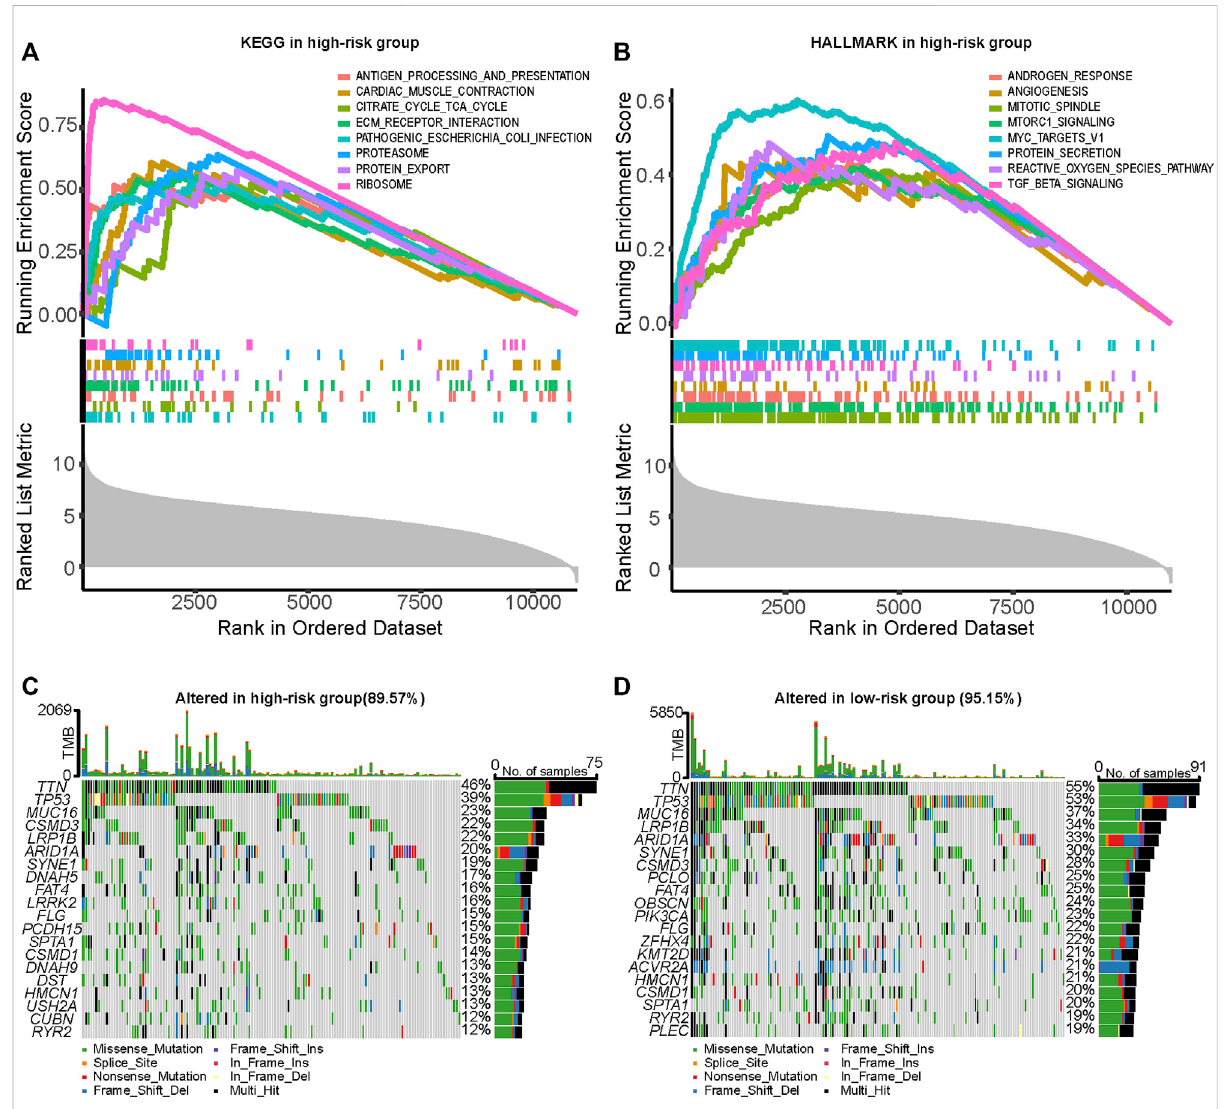
FIGURE 6 Analysis of enrichment function and genetic mutation at a different risk score. (A,B) Part of signi fi cantly upregulated pathways in the high-risk group enriched by GSEA analysis. (C,D) Comparison ofgenetic mutationbetween thehigh- and low-risk groups utilizedby the “ maftool ” Rpackage. GSEA, Gene Set Enrichment